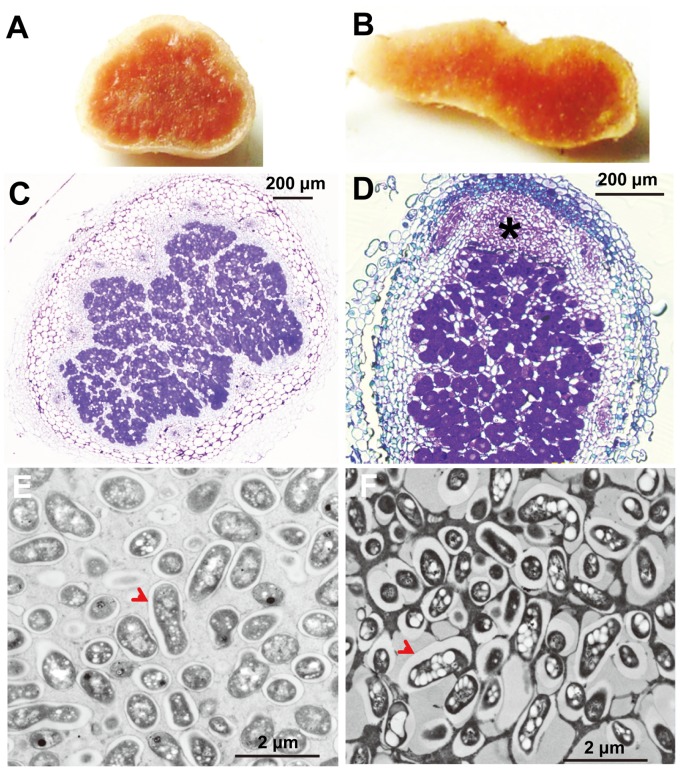
Nodule sections of Vigna unguiculata and Leucaena leucocephala.(A–B) Nitrogen fixing nodules of V. unguiculata (21 days post inoculation, A) and L. leucocephala (35 days post inoculation, B). (C–D) Semithin sections of nodules from V. unguiculata (C) and L. leucocephala (D), the asterisk indicates the meristem zone of indeterminate nodules of L. leucocephala (D). (E–F) Ultrathin sections of nodules from V. unguiculata (E) and L. leucocephala (F), red arrowheads indicate the peribacteroid membrane; and PHB granules are seen as electron-transparent droplets in the cytoplasm of bacteroids.